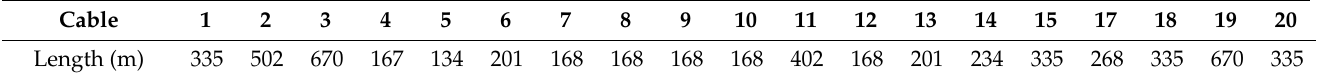
Table 2. The length of cables.